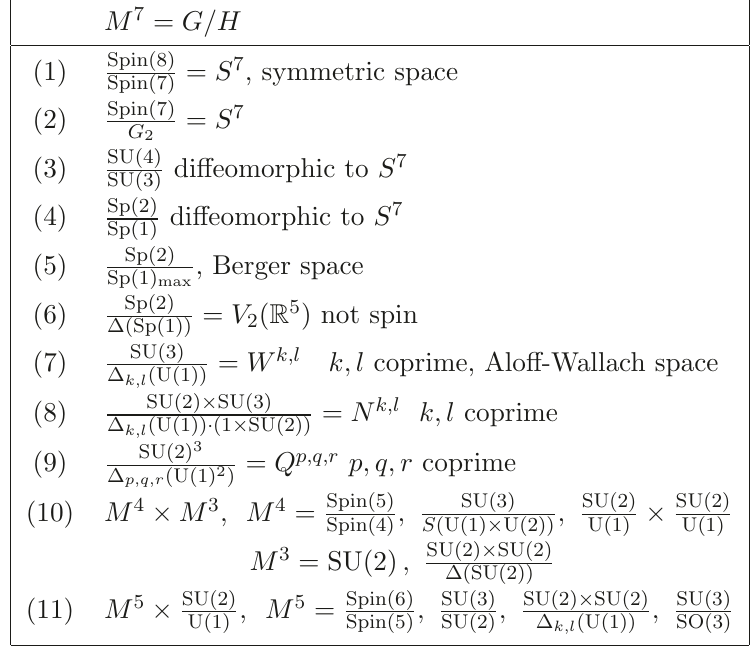
Table 9 . 7-dimensional compact, simply connected, homogeneous